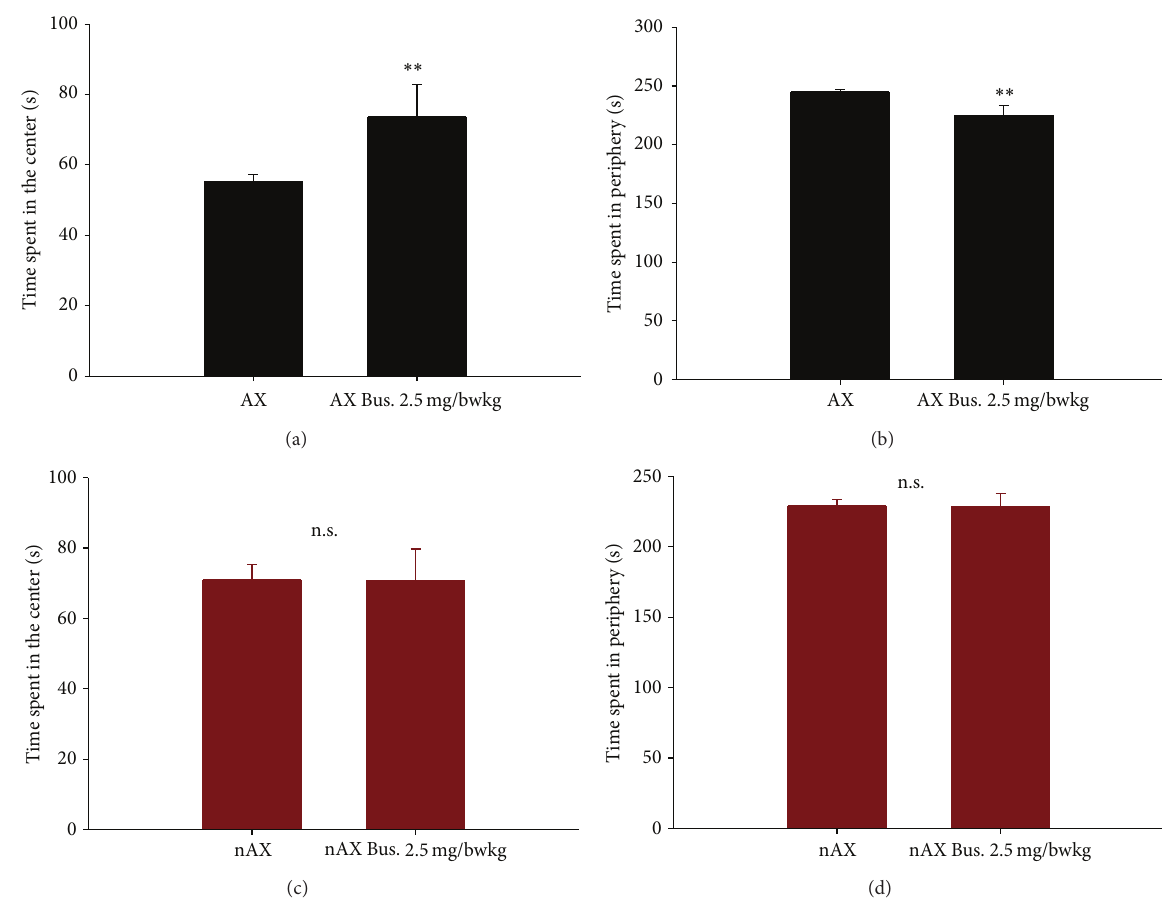
Figure 2: Buspirone decreased anxiety of AX mice in the open field test. An increase in the time spent in the center (a) and a decrease in the time spent in the periphery (b) were induced by buspirone. There was no effect of buspirone treatment on nAX mice neither in the time spent in the center (c) nor in the periphery (d). ** 𝑃 ≤ 0.01 , 𝑡